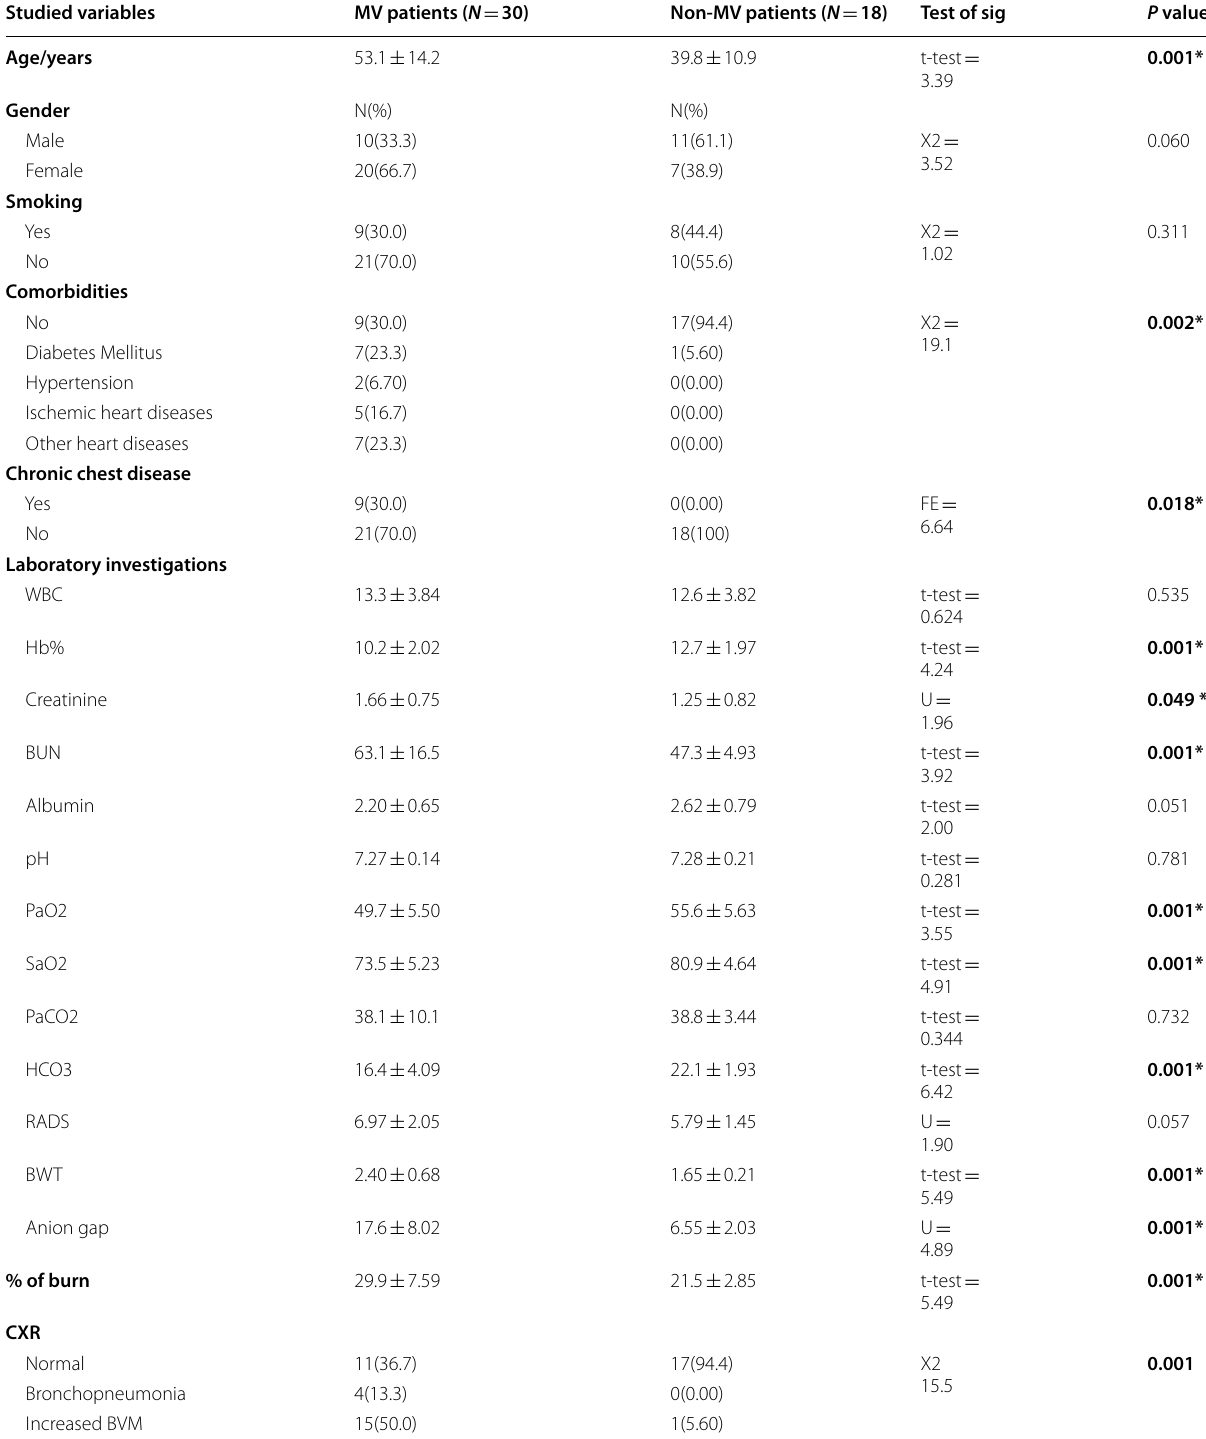
Table 5 Comparison between MV patients and non‑MV among patients with